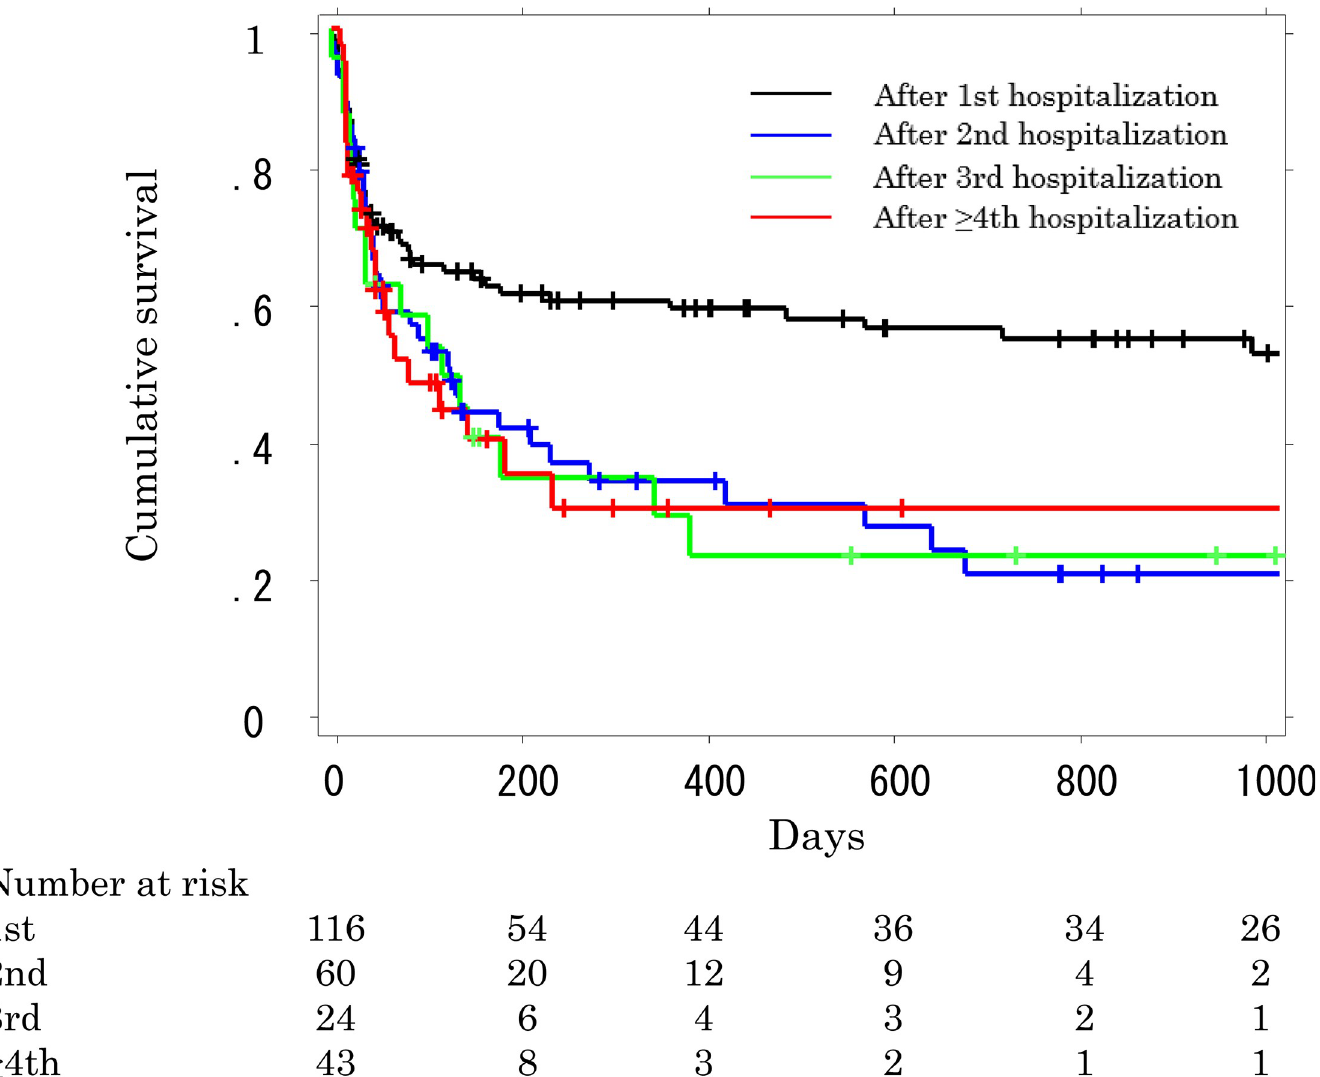
Fig 3. Kaplan-Meier survival curves of each respiratory-related hospitalization identified by ordinal number. Patients who underwent 1, 2, 3, and 4 or more hospitalizations during the study period were categorized into “After the first, second, third, and � fourth hospitalization” group, so that no patient overlapped. Survival curves were compared by the log-rank test ( P = 0.004). +: censored. RH, respiratory-related hospitalization.